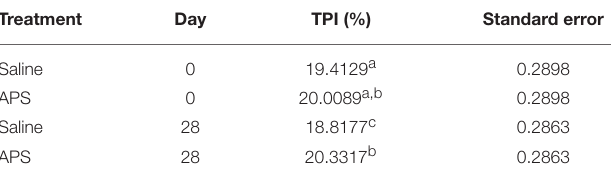
TABLE 2 | Total pressure